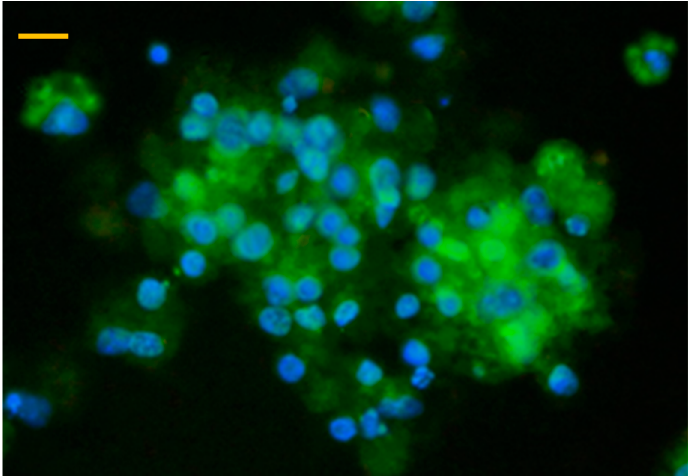
Figure 2. Immunofluorescent detection of hepatocytes in a hepatocyte—nonparenchymal cell co-culture after 48 h culturing with a chicken specific, fluorescein isothiocyanate (FITC) coupled anti-albumin antibody (40× magnification, bar = 40 µm). Blue colour indicates cell nuclei with DAPI staining, while green colour refers to hepatocytes detected with the FITC conjugated antibody.